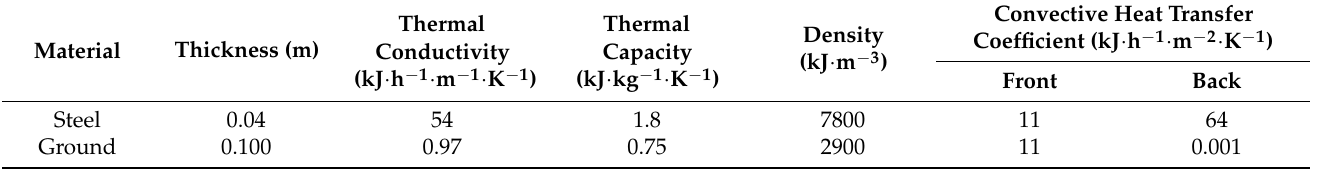
Table 5. Opaque materials’